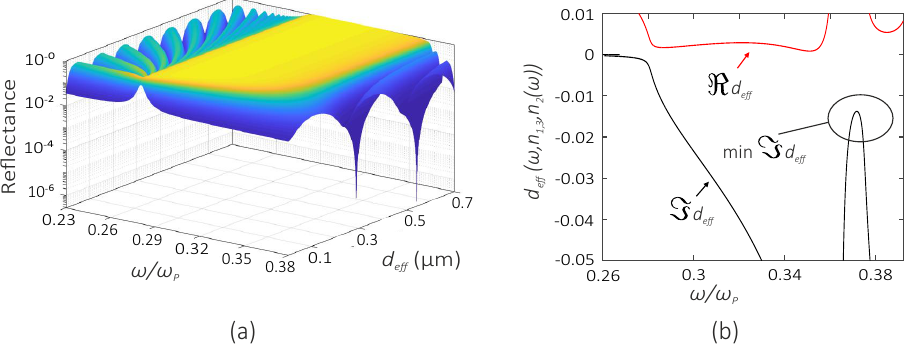
Figure 10. Graphic solution of Equation (7) ( a ) and Equation (8) ( b ) at a nanocomposite filling factor of f =